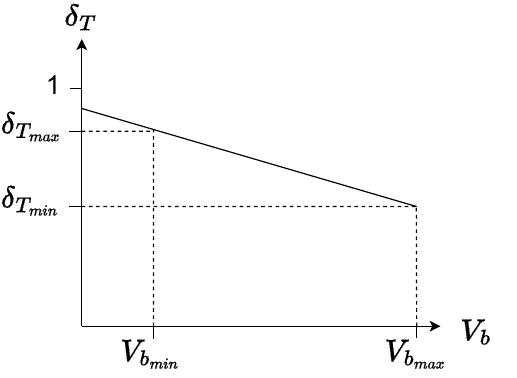
Figure 7. Relationship between battery voltage and thrust control signal. For a constant flight condition, a linear relationship will be maintained between both values.